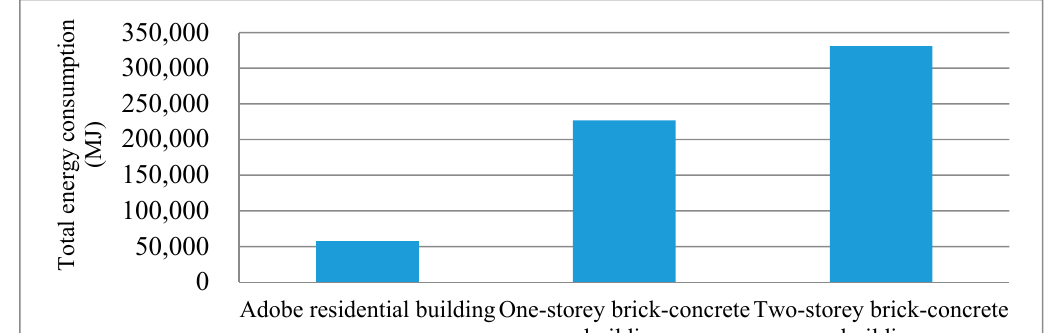
Figure 6. Total energy demand in building materials manufacture (MJ).